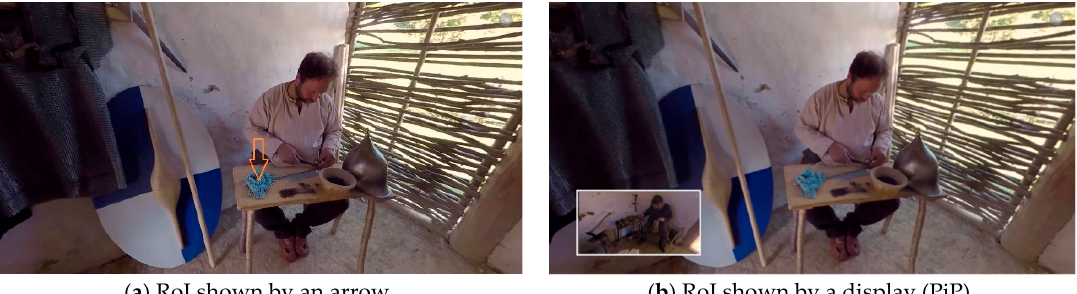
Figure 1. Two overlay methods for CVR (Images taken from our work).